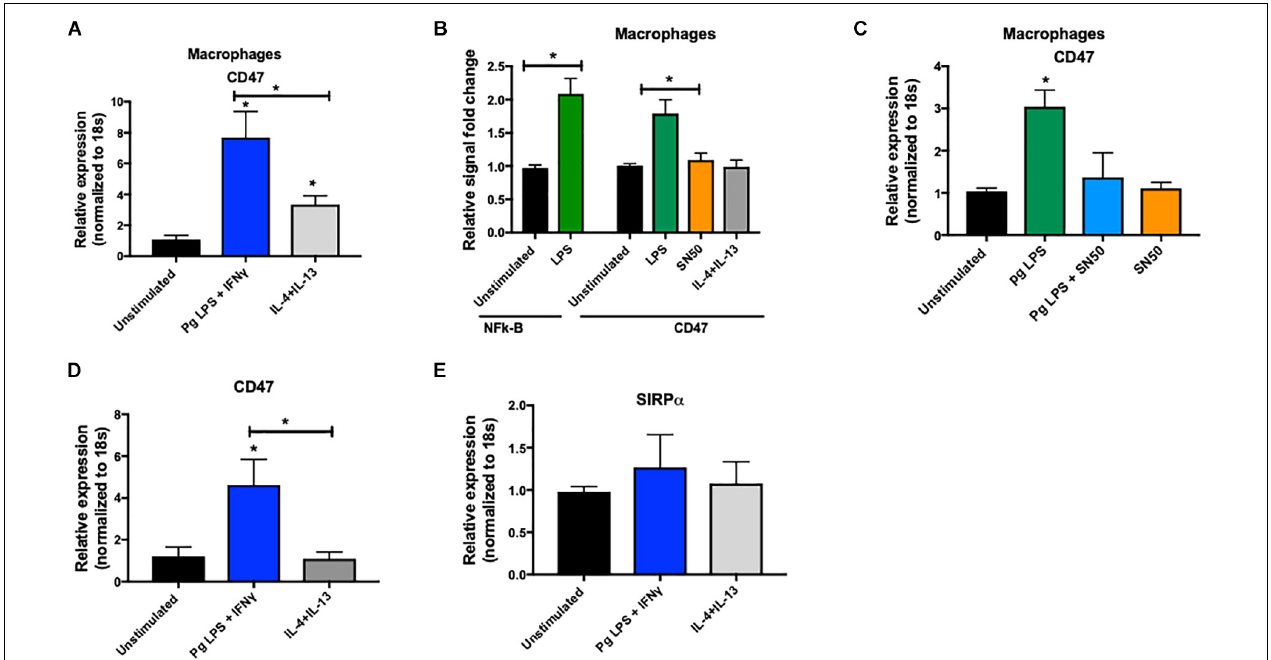
FIGURE 7 | (A) THP1-derived macrophages were challenged with P. gingivalis LPS (10 ng/ml) and IFN γ (20 ng/ml) (M1 phenotype), or IL4 (40 g/ml) + IL13 (20 ng/ml) (M2 phenotype). Level of CD47 mRNA was quantified by qPCR after 24 h (at least 5 donors in each group). Data were normalized to 18 s. (B) Luciferase reporter assay was used to asses NF- κ B and CD47 promoter activity in THP1-derived macrophages after challenge with P. gingivalis LPS or SN50 (20 µ M). (C) THP1-derived macrophages were challenged with P. gingivalis LPS (20 ng/ml) and/or SN50 (20 µ M) and level of CD47 mRNA was quantified by qPCR. Data were normalized to 18 s. (D,E) Primary human macrophages were challenged with P. gingivalis LPS (10 ng/ml) and IFN γ (20 ng/ml) (M1 phenotype), or IL4 (40 g/ml) + IL13 (20 ng/ml) (M2 phenotype). Levels of CD47 and SIPR α mRNA were quantified by qPCR after 24 h (at least 5 donors in each group). Data presented as mean ± SEM and p less than 0.05 was defined as significant (the symbol “*” depicts p < 0.05 compared to the unstimulated control, unless otherwise noted in the